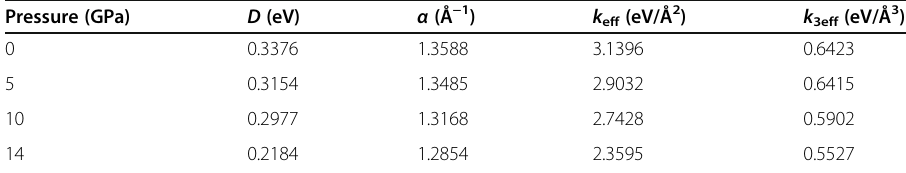
Table 3 Morse potential parameters, spring force constants, and cubic parameters under pressure effects up to 14GPa Pressure